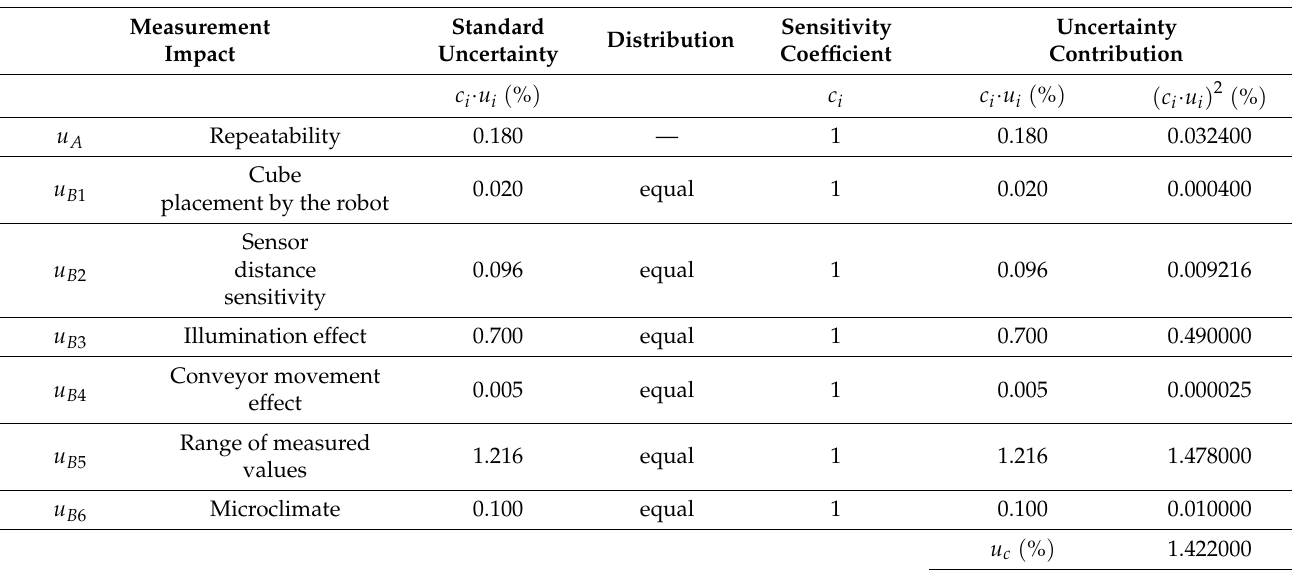
Table 13. Balance table of uncertainties for the brown